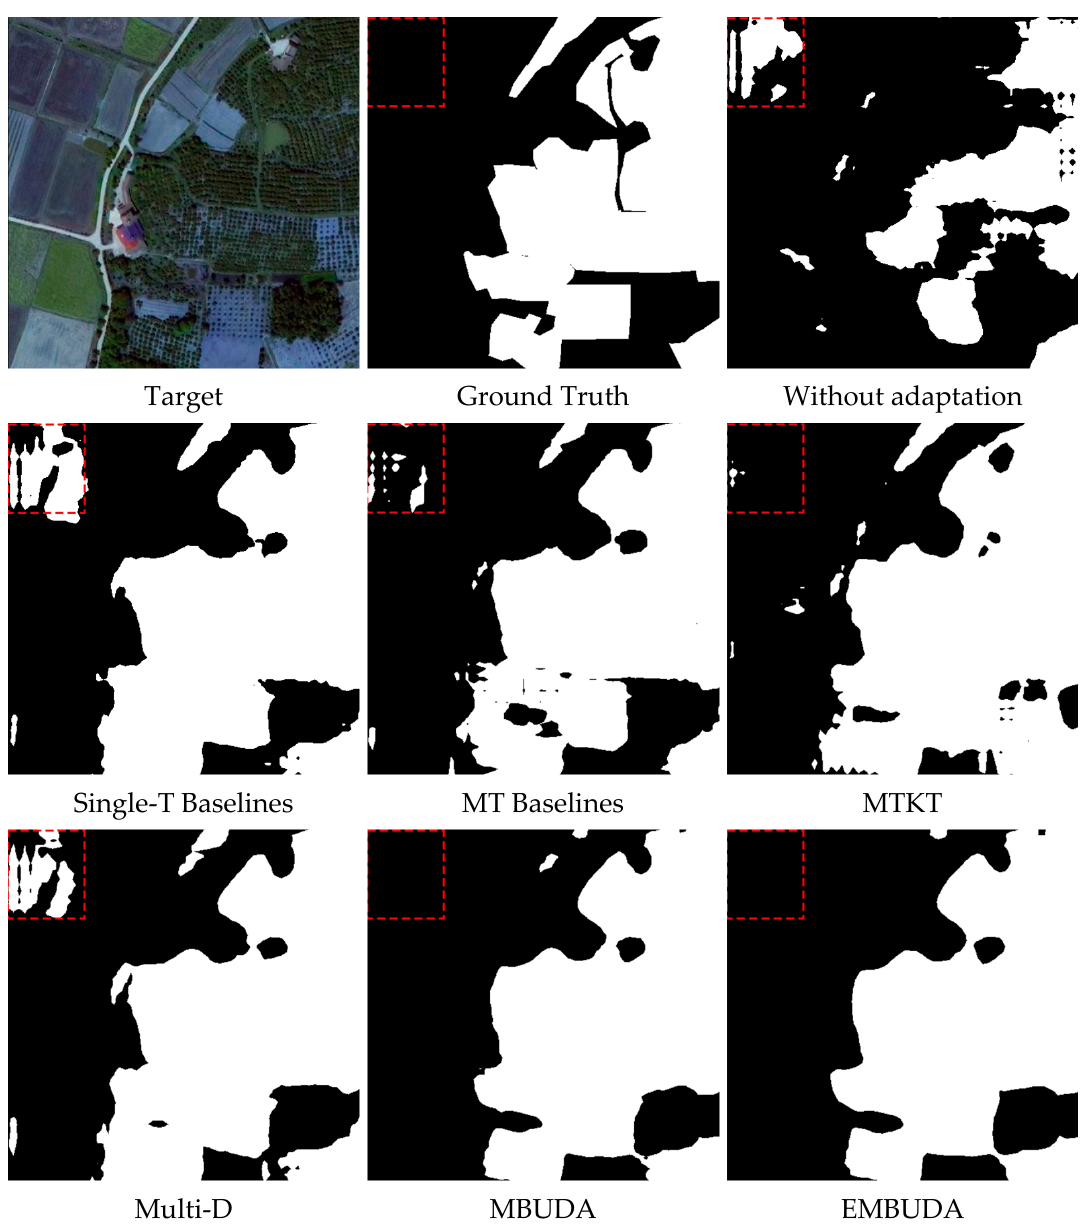
Figure 6. Outputs of orchard area segmentation in Dataset XT1 when adapting from Dataset ZG to Dataset CY and Dataset XT1.